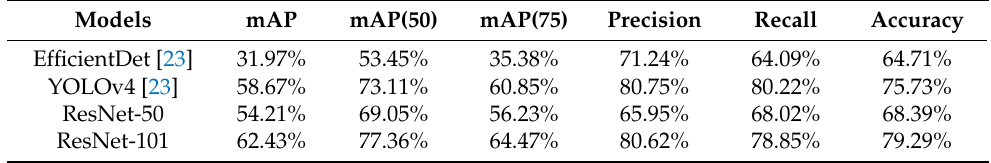
Table 2. Performance comparison between deep-learning models applied to hair follicle classification.